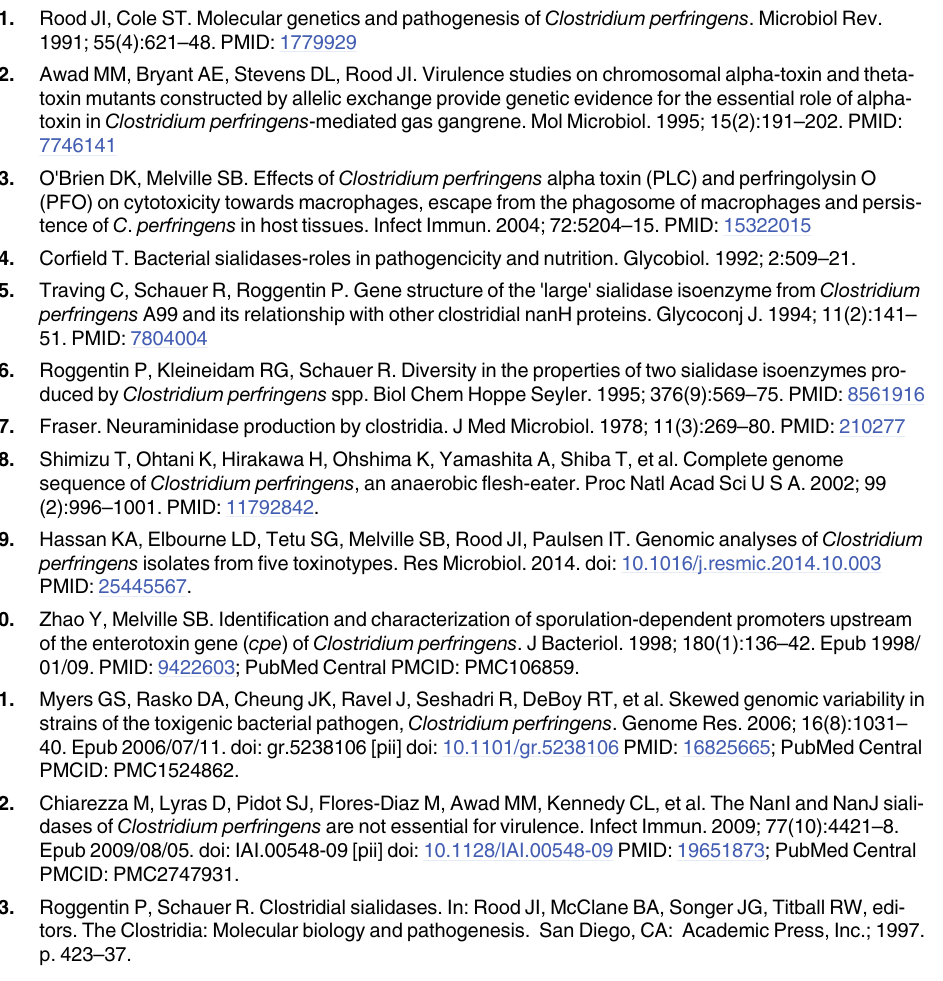
S3 Fig. Gel mobility shift experiments with NanR and the nanJ and nanR promoter regions. Gel mobility shift assays with the nanJ (left panel) and nanR (right panel) promoter regions that were PCR amplified as described in the Materials and Methods of the main text. S1 Text. Figure Legends and Methods for Supporting Information.